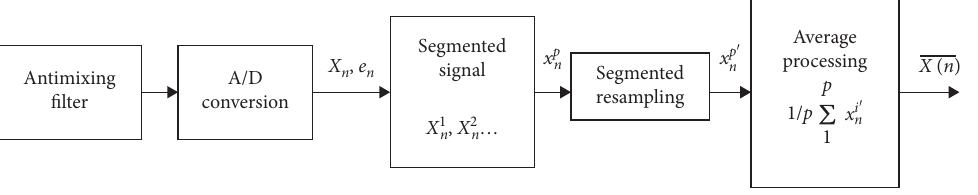
Figure 2: Improved process.